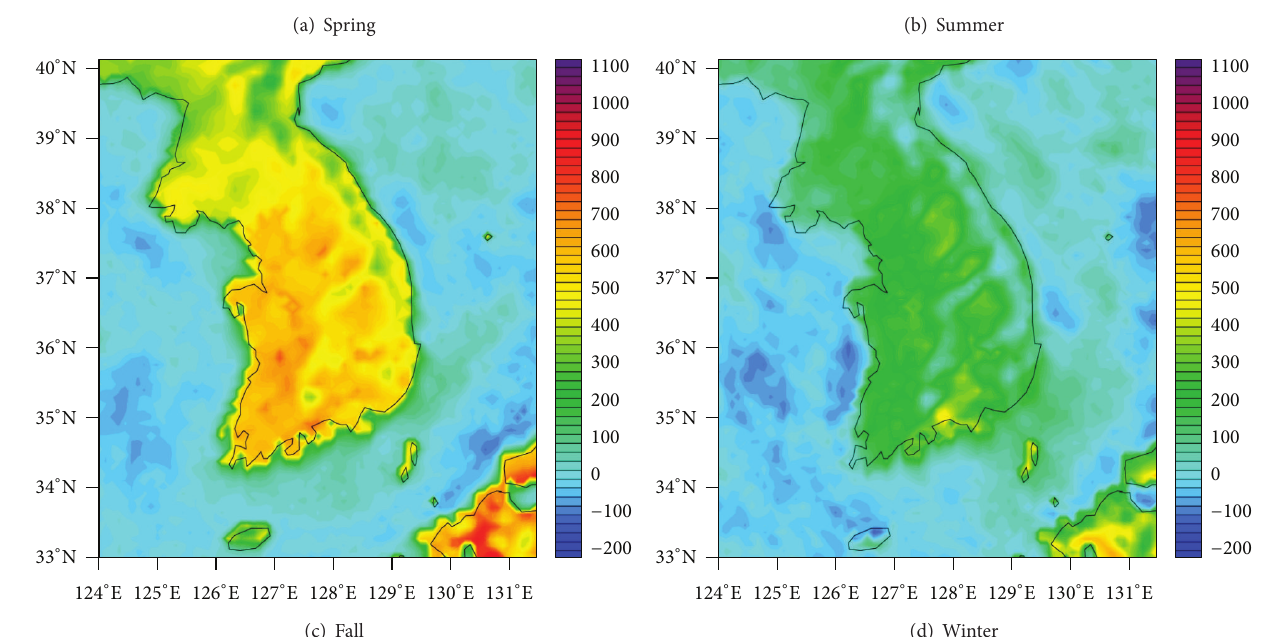
Figure 7: Same as Figure 6, but for morning growth rate of